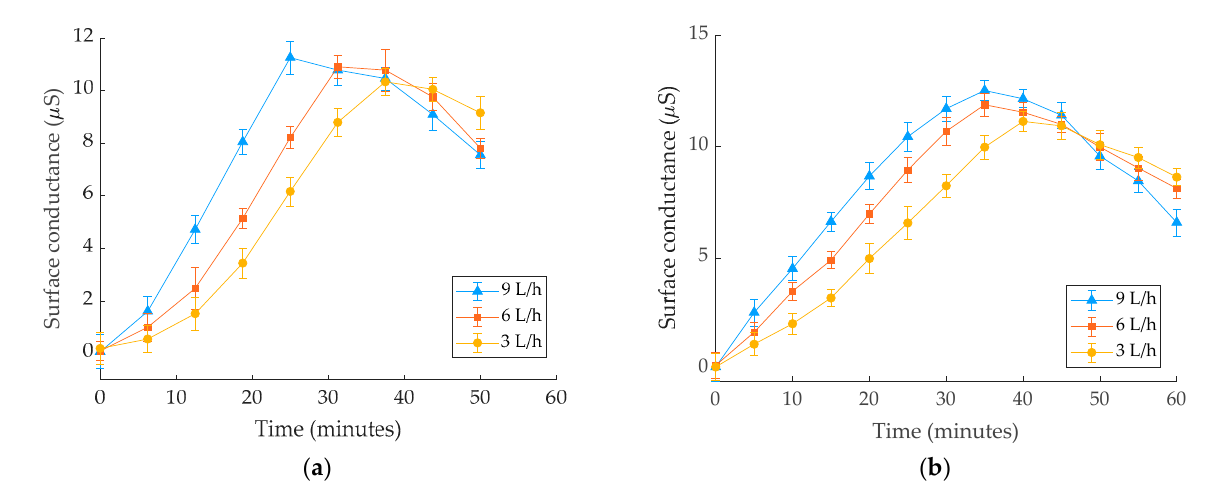
Figure 4. Surface conductance behavior of ( a ) insulator type I; ( b ) insulator type II under different rain flow rates. Table 2. Maximum values of conductance for five tests, average conductance, and standard devia- tion of surface conductance when the insulators were saturated with water.